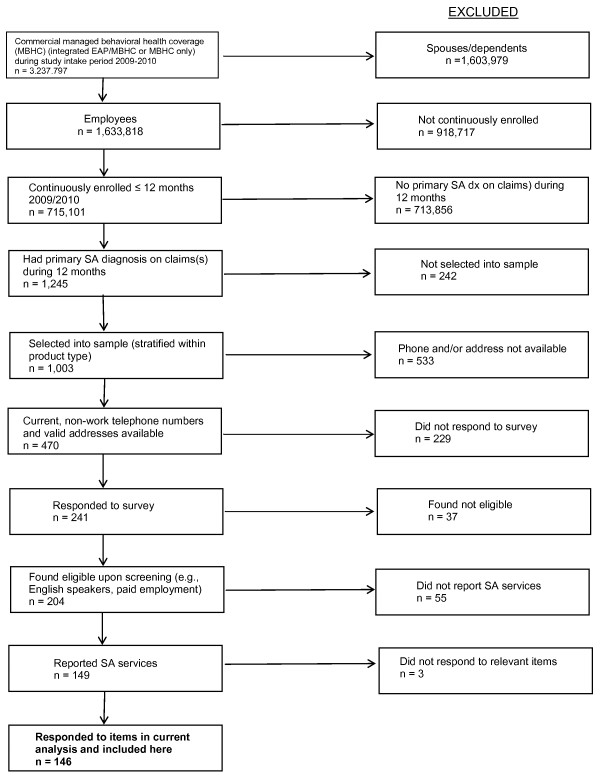
Sampling Approach.